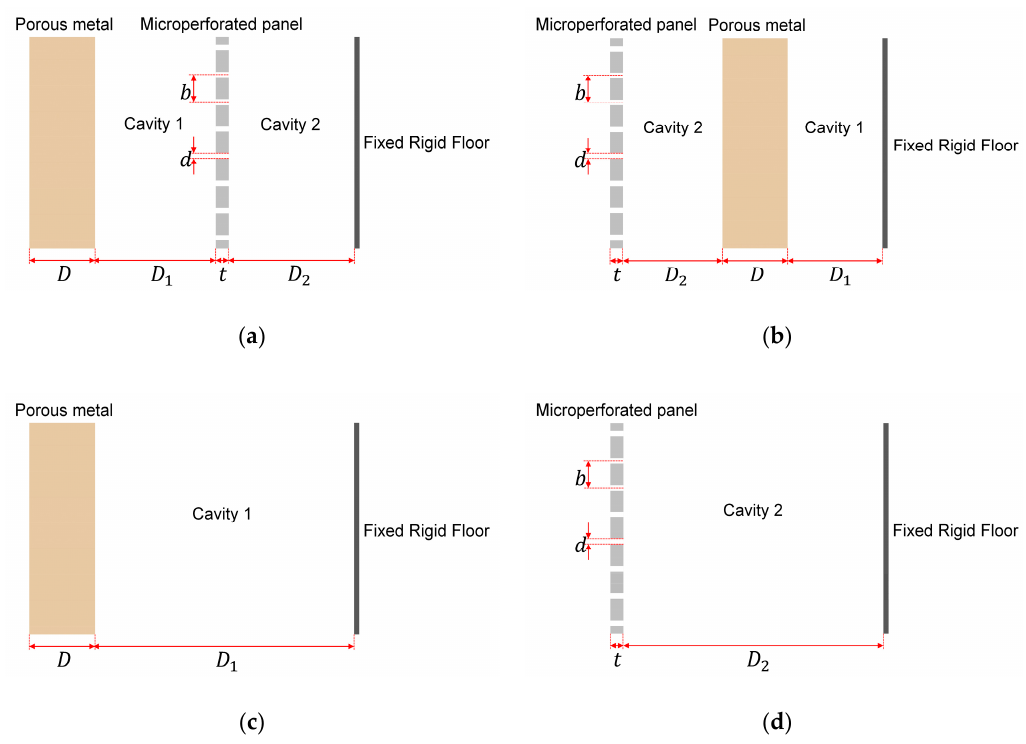
Figure 1. Schematic diagrams of the investigated sound absorbing structures. ( a ) Porous metal + cavity + microperforated panel + cavity; ( b ) Microperforated panel + cavity + porous metal + cavity; ( c ) Porous metal + cavity; ( d ) Microperforated panel + cavity.